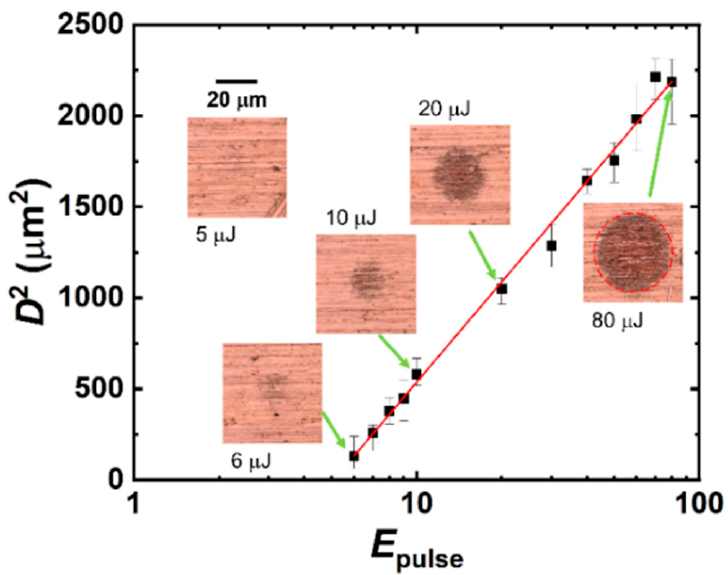
Figure 1. Relationship between the laser pulse energy ( E pulse ) and the spot diameter square of the discolored area ( D 2 ). The discolored area is shown in the inserted CLSM images.